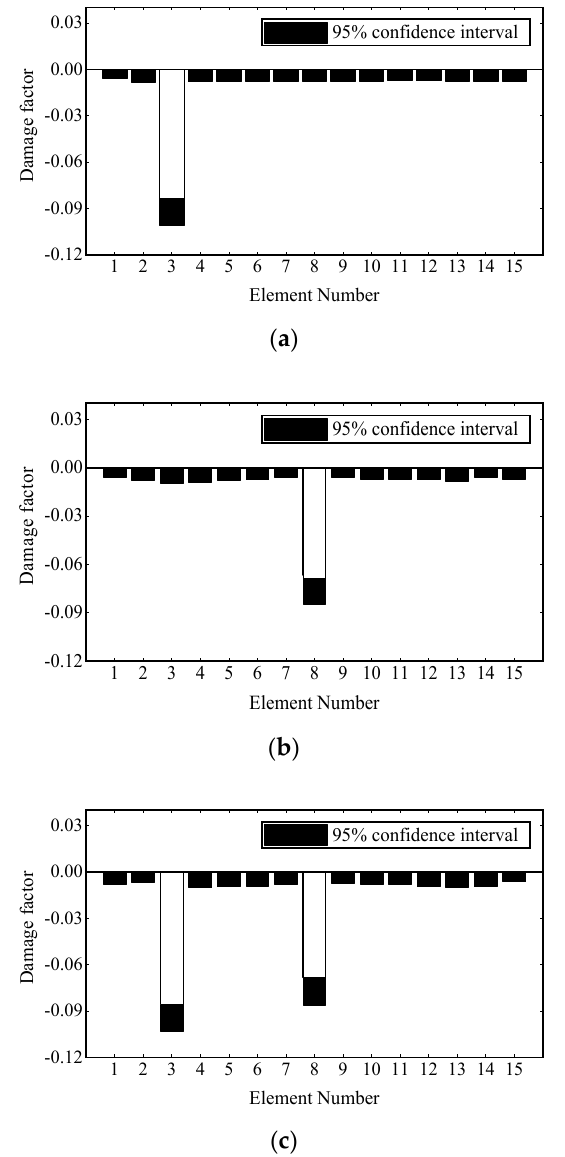
Figure 8. Damage identification results under 20% noise: ( a ) scenario 1; ( b ) scenario 2; ( c ) scenario 3.